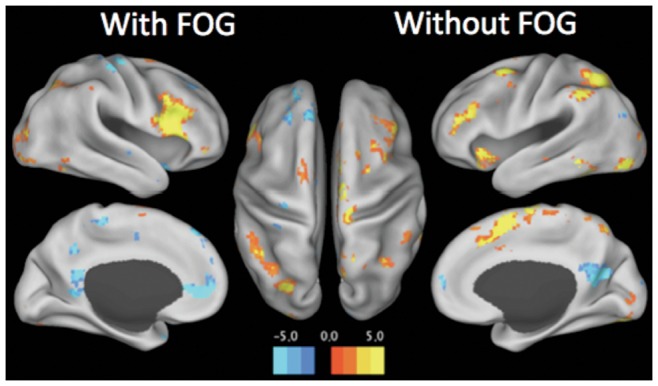
Within-group similarities.Cortical surface rendering of the major areas of increased and decreased BOLD response during the comparison of the Indirect WALK cue and the Direct WALK cue. A similar pattern was seen when comparing PD patients with and without FOG. Colour intensity on the graph represents the t-value obtained from the 2nd-level analysis of each group (corrected with a false detection rate of p<0.05).